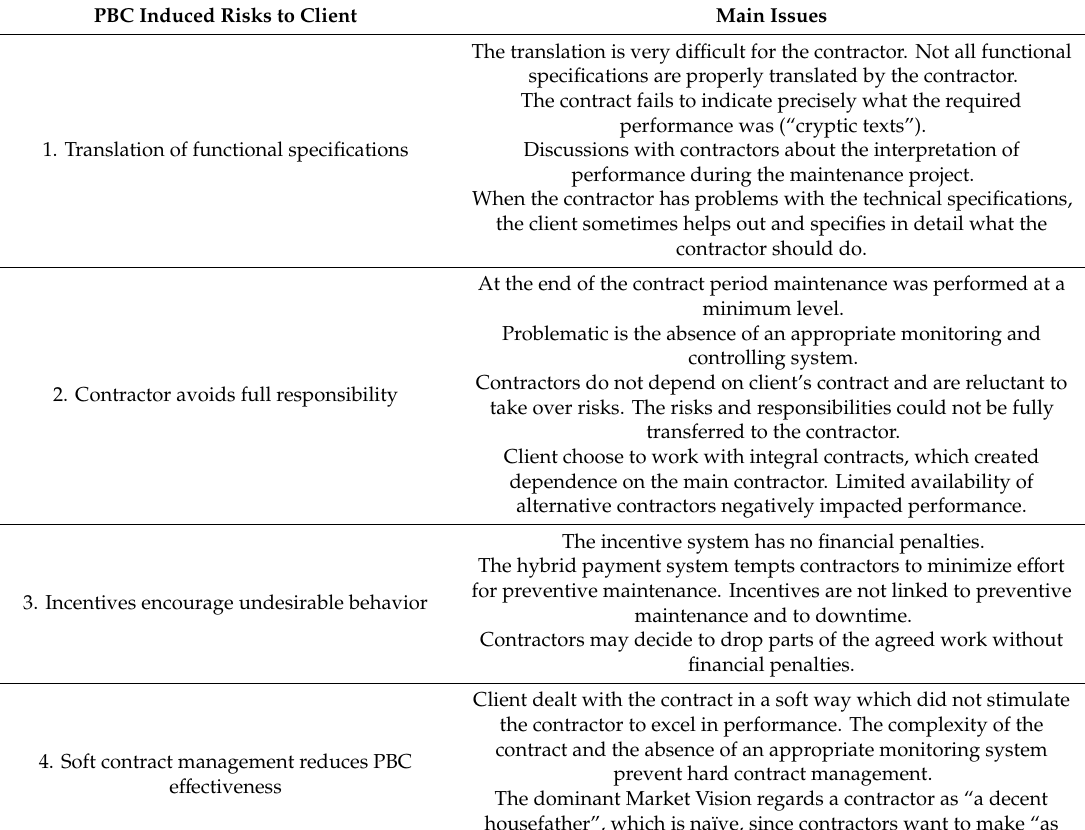
Table 1. Empirical results from the